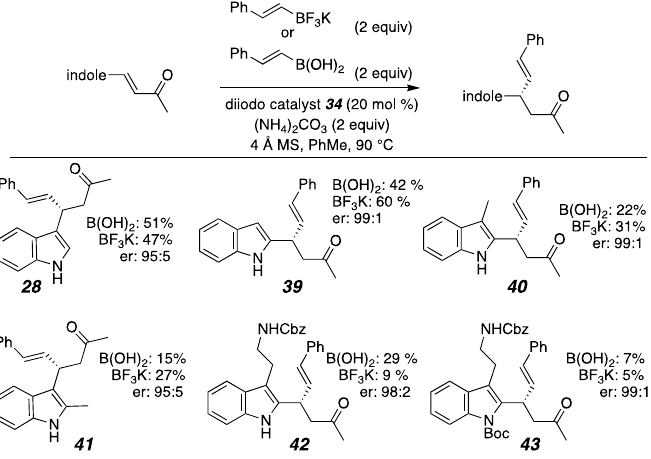
Figure 9. Indole substrates (NMR spectra and HPLC data in Supplementary Materials).